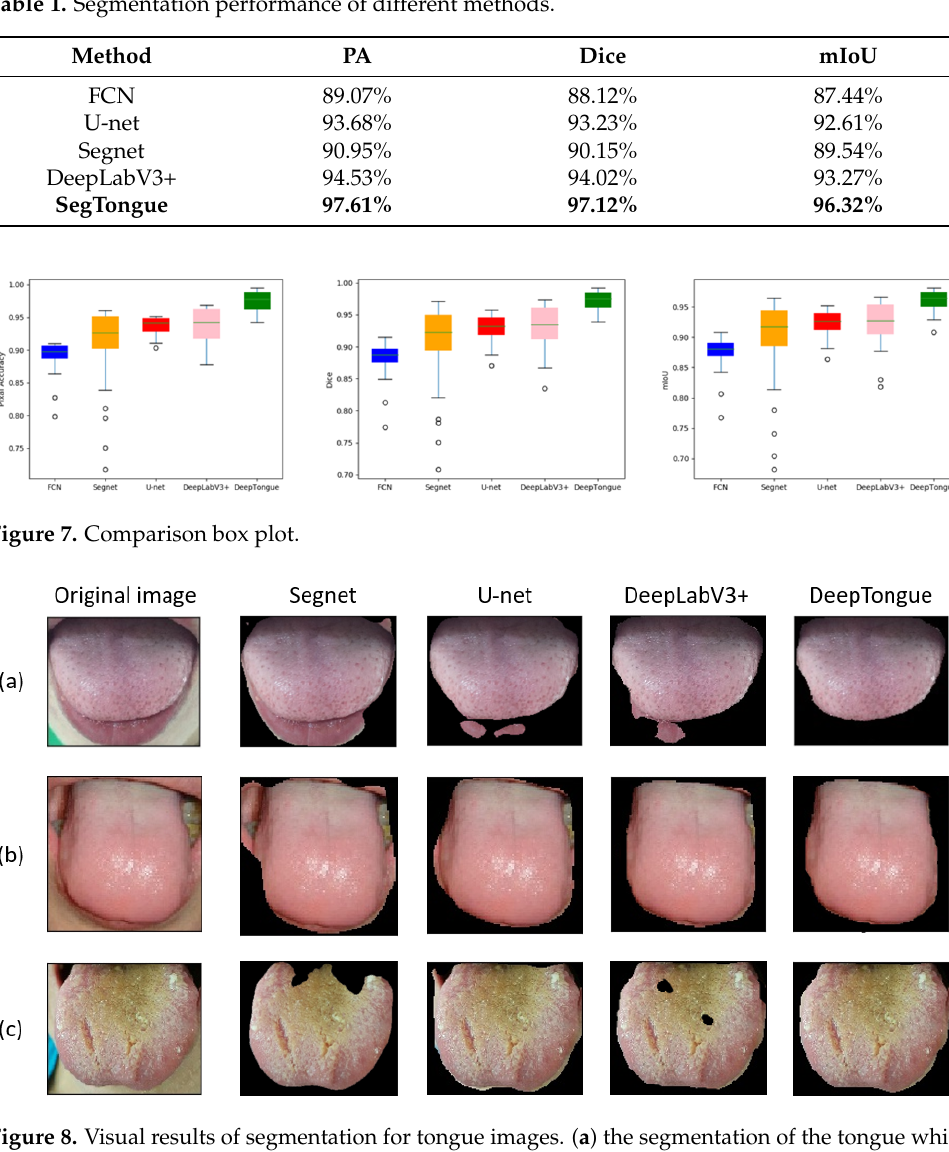
Figure 8. Visual results of segmentation for tongue images. ( a ) the segmentation of the tongue which is severely affected by the lips, ( b ) the segmentation of the tongue which is severely affected by the lips and teeth and ( c ) the tongue is covered with a layer of green tongue fur, resulting in an abnormal color. 4.3. Experiment Result of Classification 4.3.1. Evaluation Criterion To evaluate the performance of the proposed method on tongue image classification, we adopt some effective evaluation indicators such as overall accuracy (OA), individual